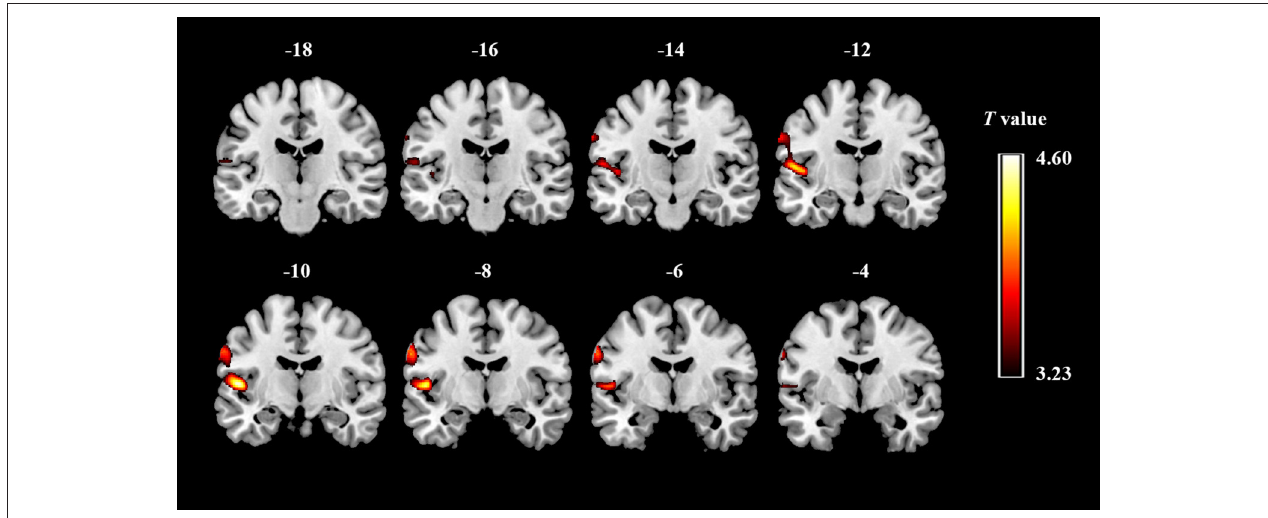
FIGURE 1 | Gray matter regions that discriminate between the groups of ASD and typically developing controls. Red indicates areas of increased gray-matter volume in ASD (ASD > TD).